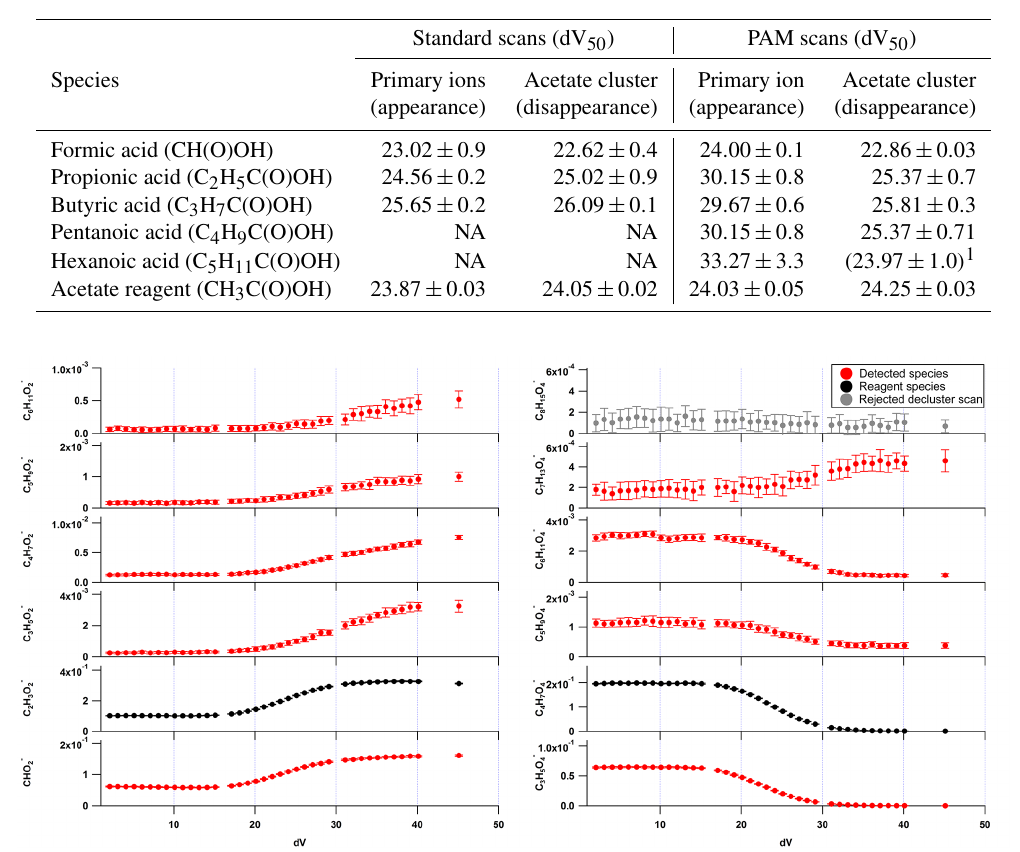
Figure 11. Individual alkanoic acid scans obtained during the scanning PAM chamber experiment (left) and [alkanoic acid + acetate] cluster scans